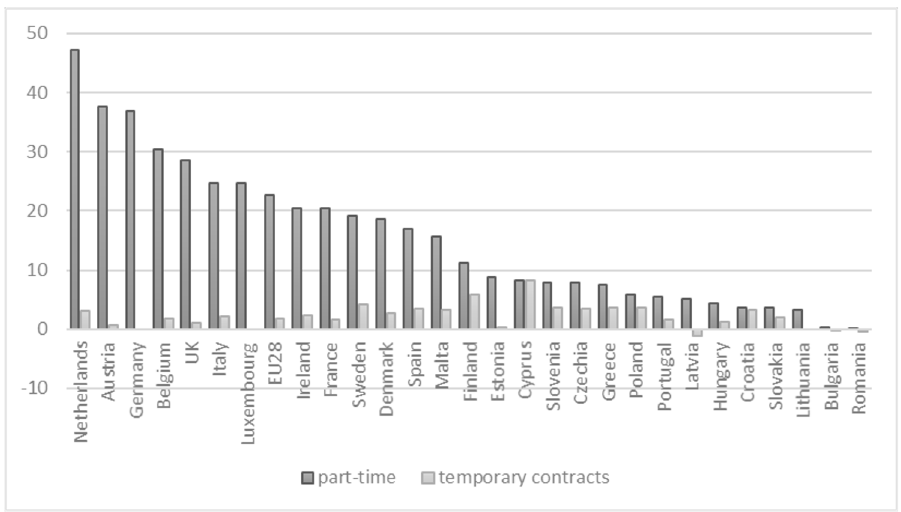
Figure 1. Gender gap (between females and males) in part-time employment and temporary contracts in EU countries in 2019 (pp based on the gaps between % of total employment in the group on females and males, 15–64